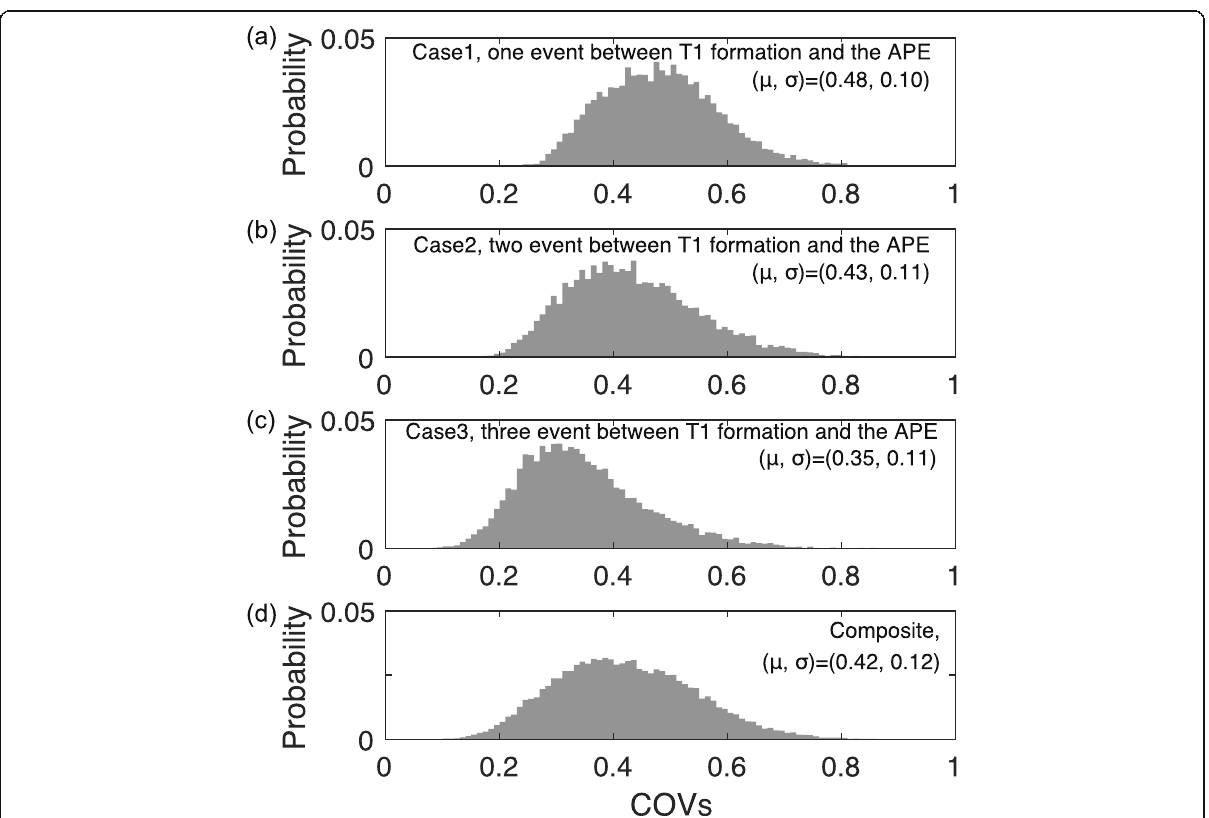
Fig. 12 Probability distributions of COVs. a Case 1 assumes that one earthquake occurred at Oide during the period between T1 formation and the APE. b Case 2 assumes that two earthquakes occurred at Oide in the modeled period. c Case 3 assumes that three earthquakes occurred at Oide in the modeled period. d A composite histogram of all cases. All cases include the maximum and minimum thresholds of slip per